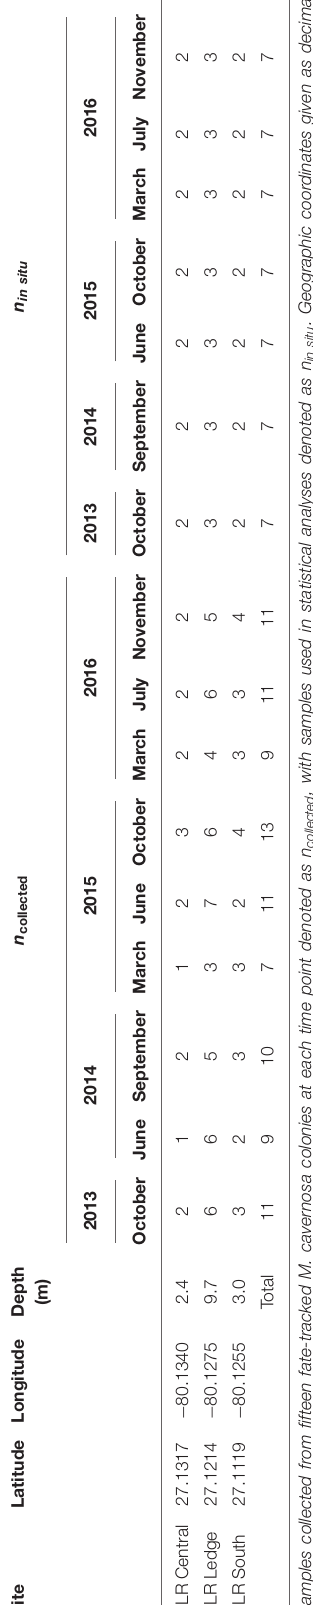
prevented collection of tissue samples from all colonies at each time point. Sampling occurred at three sites along St. Lucie Reef (SLR Central, SLR Ledge, SLR South; depths ranging from 2.4 to 9.7 m; Table 1 and Figure 1 ) with increasing distance from the St. Lucie Inlet, which has been shown to approximate a gradient of decreasing exposure to estuarine discharge water (Beal et al., 2012; Shatters, 2017). Cumulative estuarine discharge flow rates measured at the canals C-44, C-23, C-24, and Ten Mile Creek ( Figure 1 ) were obtained from the South Florida Water Management District’s DBHYDRO database ( Supplementary Figure 1 ), where daily flow rates were averaged for 2 weeks leading up to the corresponding sampling time points. Daily rainfall data were obtained from the same database at the C-44 canal control structure. Small tissue fragments ( ∼ 5 cm 2 )